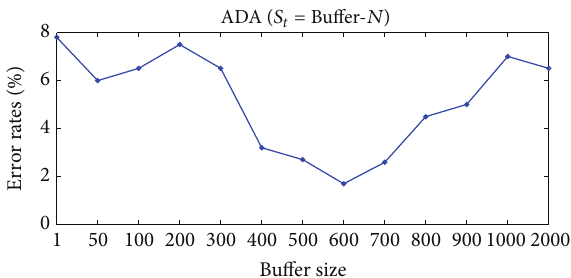
Figure 9: Error rates of ADA (Buffer- 𝑁 ) with different buffer sizes on the rotating two-moons-two-lines synthetic data